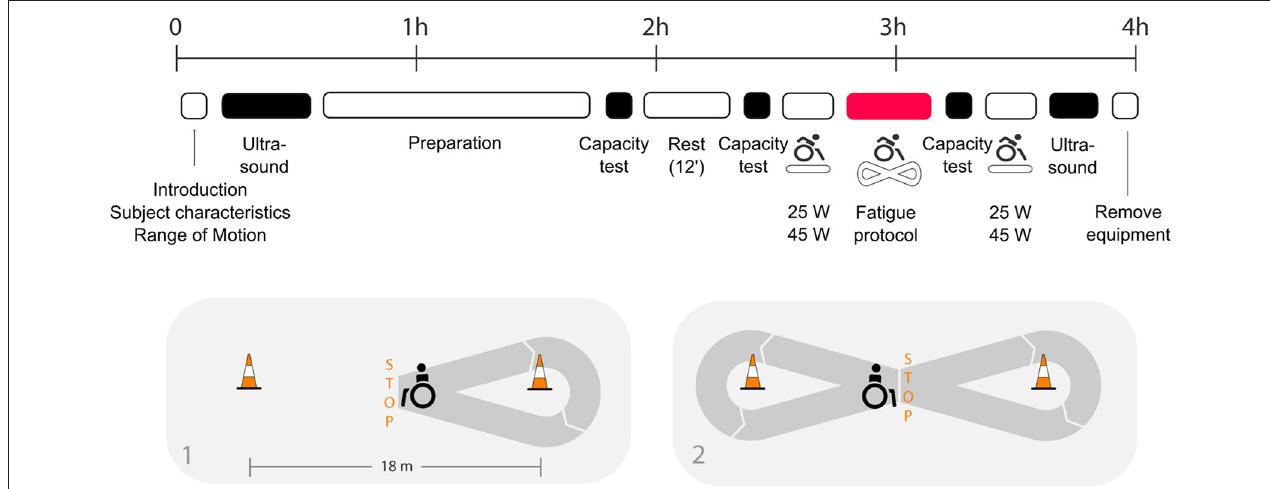
FIGURE 1 | Figure adjusted from (12): timeline of the assessments taken in the biomechanical laboratory including (1) introduction, self-reported subject characteristics and measurements of the shoulder range of motion, (2) ultrasound exams (pre and post fatigue), (3) preparation phase including a test to define individual drag force and familiarization with treadmill propulsion and fatigue protocol, (4) wheelchair user capacity test (capacity test): three maximum push tests and a maximum 15m overground sprint test (pre and post fatigue), (5) passive rest phase, (6) manual wheelchair (MWC) propulsion at two different conditions (25 and 45W, pre and post fatigue), and (7) fatigue protocol: overground wheelchair propulsion along an eight-shaped course. The detailed course of the fatigue protocol is presented below the timeline.